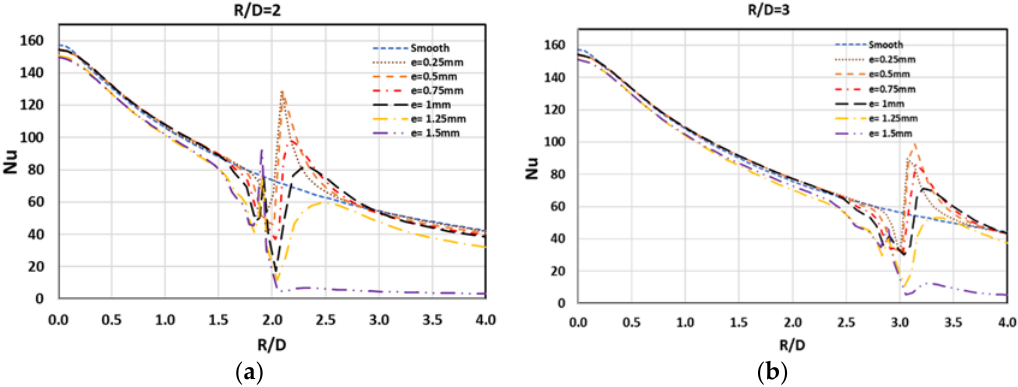
Figure 10. Local N (cid:2931) distributions for six rib heights at ( a ) R/D = 2 and ( b ) R/D = 3. Figure 10. Local N u distributions for six rib heights at ( a ) R/D = 2 and ( b ) R/D = 3. Energies 2018 , 11 , x FOR PEER REVIEW